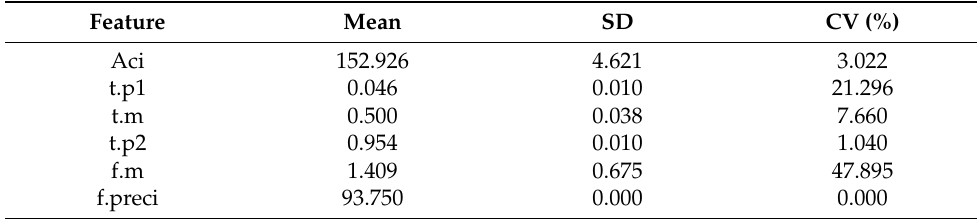
Table 7. Descriptive statistics of six descriptors.